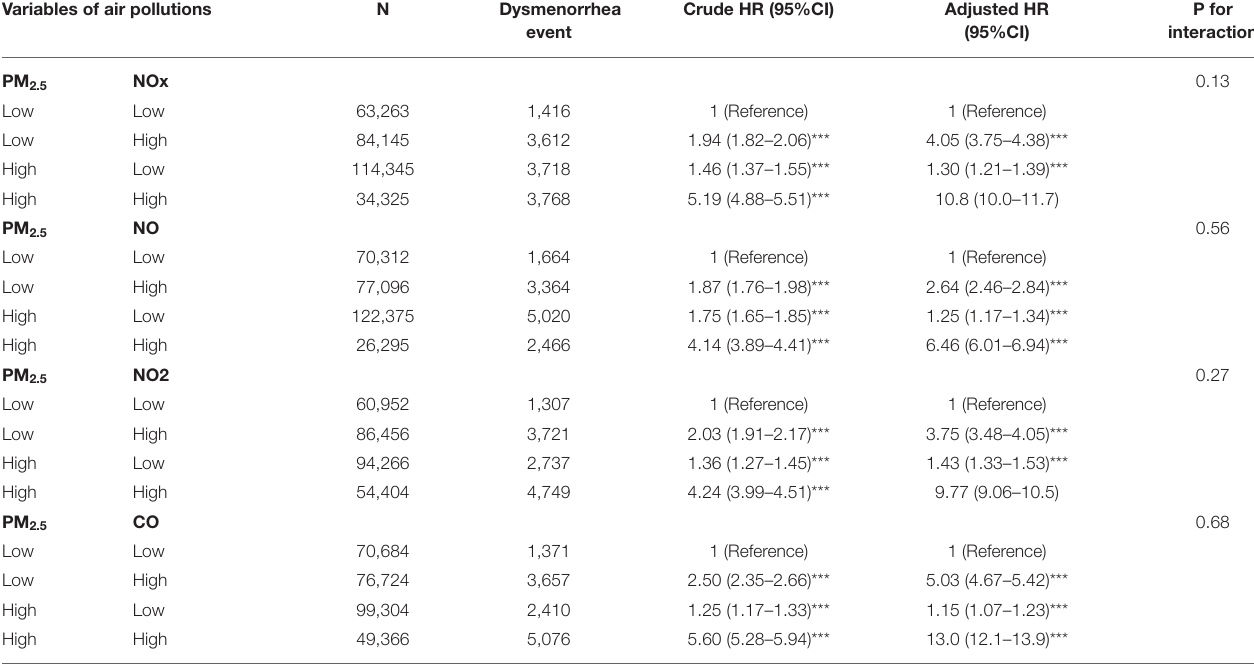
TABLE 5 | Cox proportional hazard regression analysis for the interactive effects of PM 2.5 with NOx, NO, NO 2 , and CO on the risk of dysmenorrhea association. Variables of air